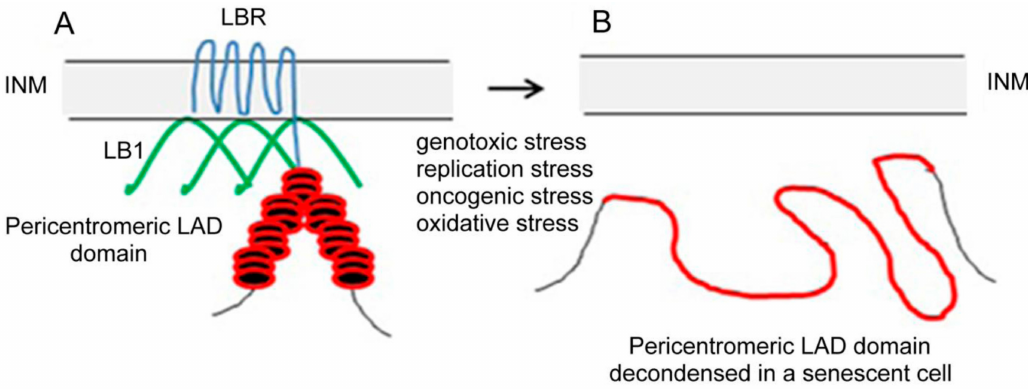
Figure 1. Schematic representation of a pericentric heterochromatin LAD domain (red) and lamin B1 (green) anchorage to INM (grey) by means of LBR (blue) in an interphase nucleus of a cancer cell ( A ) and distended pericentric heterochromatin LAD domain in a senescent nucleus ( B ). In (B) the LAD domain of a pericentric heterochromatin is no longer attached to INM because LBR that anchored this condensed domain to INM in interphase nucleus was lost together with LB1 after cell transition to senescence. The loss of both proteins in senescence leads to the relocation of pericentric heterochromatin from INM to the nucleoplasm and to its